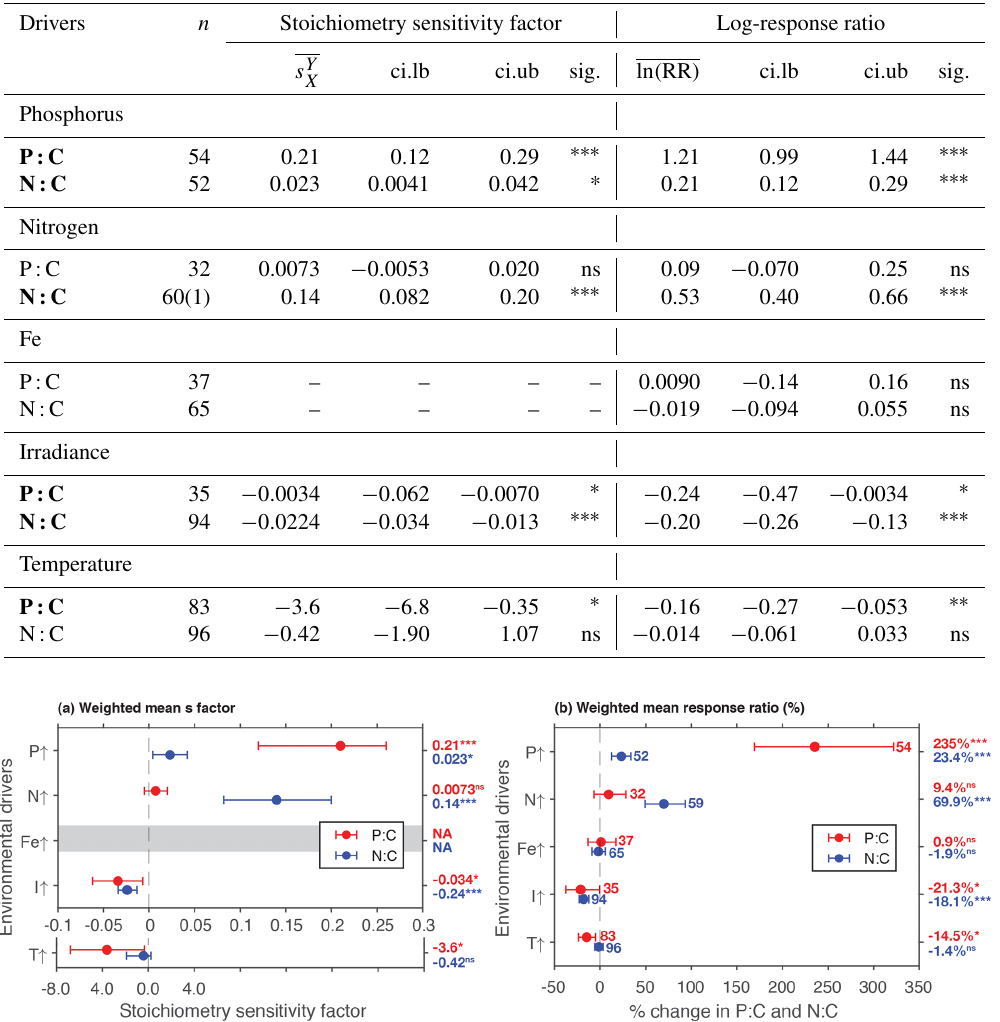
Table 2. Summary of the meta-analysis using the stoichiometry sensitivity factor and natural-logarithm-transformed response ratio. n , number of experimental units (numbers in bracket represent the number of outlier studies); s Y , weighted mean stoichiometry sensitivity factor with X environmental driver X and response variable Y ; ln ( RR ) , weighted mean value of the natural-logarithm-transformed response ratio; ci.lb, lower boundary of 95% CI; ci.ub, upper boundary of 95% CI; sig., significance of the mean weighted effect size; ns, P > 0 . 05; ∗ P < 0 . 05; ∗∗ P < 0 . 01; ∗∗∗ P < 0 . 001. Any experiment with a studentized residual value of ln ( RR ) exceeding 3 was removed as an outlier. Bold texts highlight statistically significant environmental drivers.